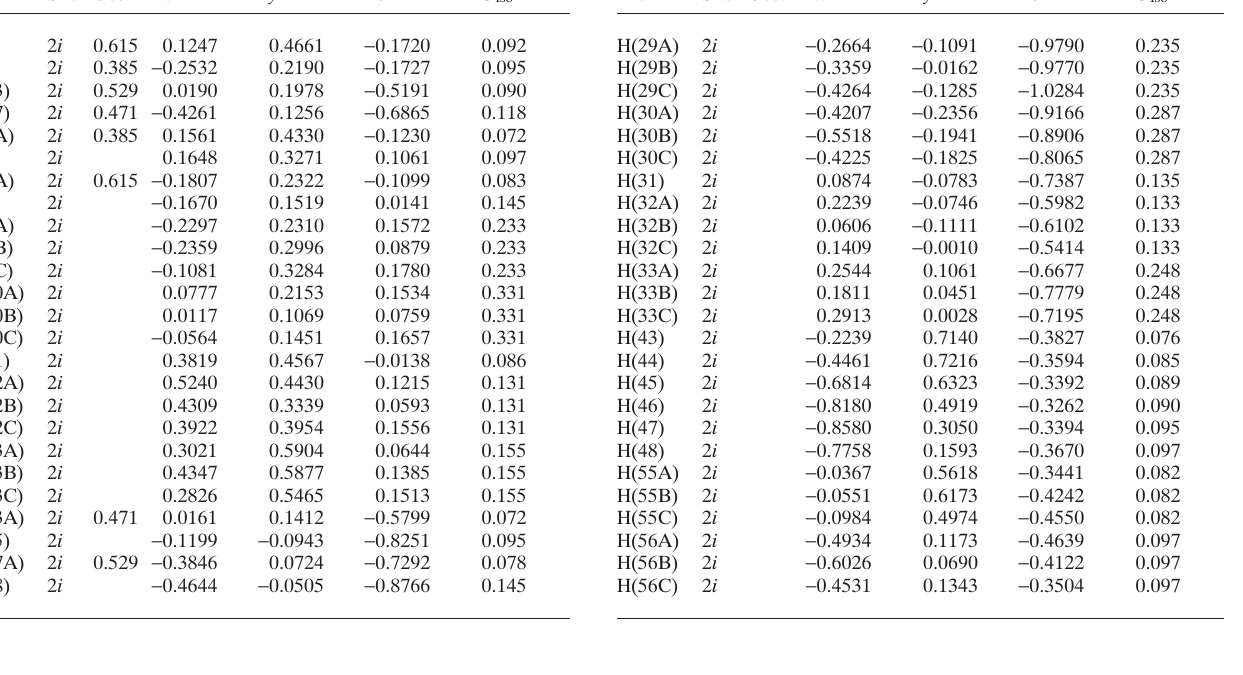
Table 3. Atomic coordinates and displacement parameters (in Å 2 ) .